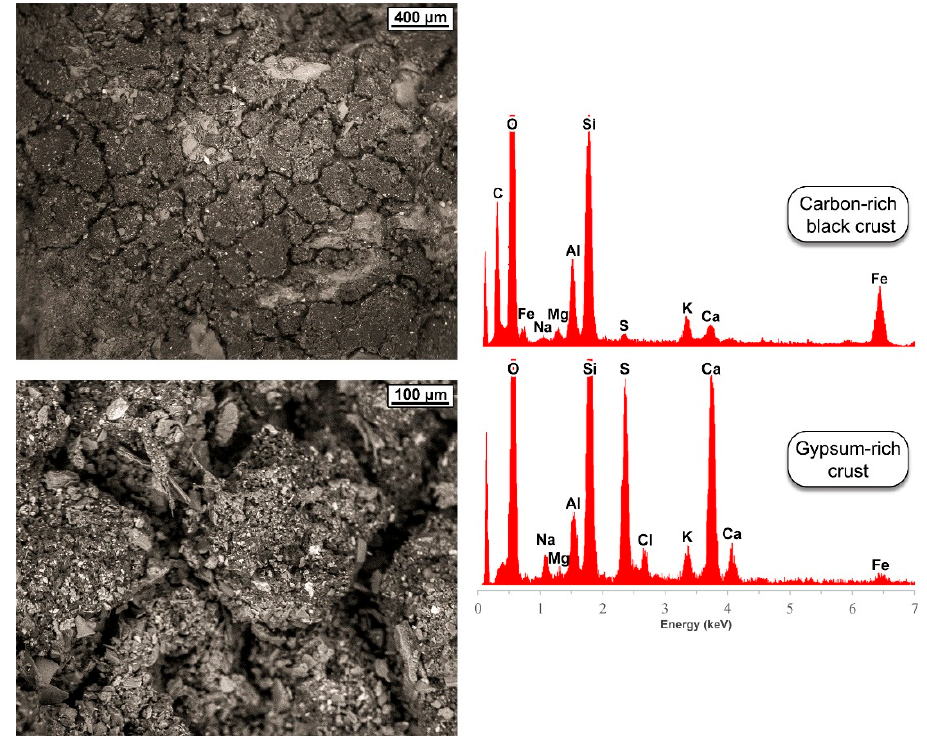
Figure 4. SEM-BSE photomicrographs showing at different magnifications a microcracked C-rich black crust on the historical walls of Eger Castle. The EDS spectra show the microchemical composition of the same crust and of a gypsum-rich crust from another sampling point.